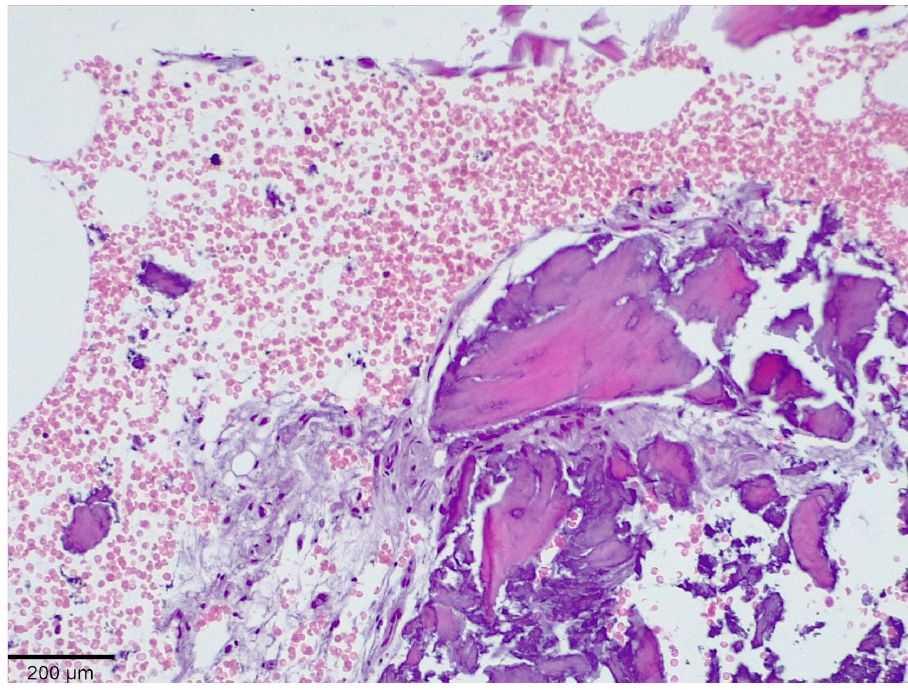
Figure 3. Evaluation at three months, in which one can see dentin particles surrounded by connective tissue. No inflammation was observed.